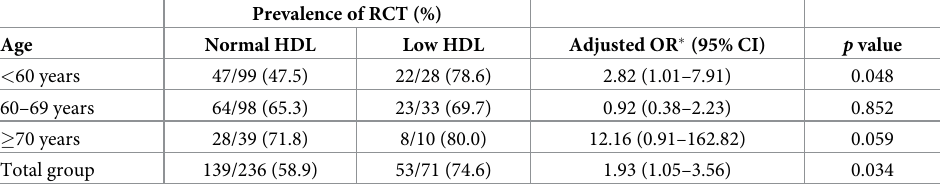
Table 4. Association between high-density lipoprotein cholesterol and rotator cuff tear in relation to age.